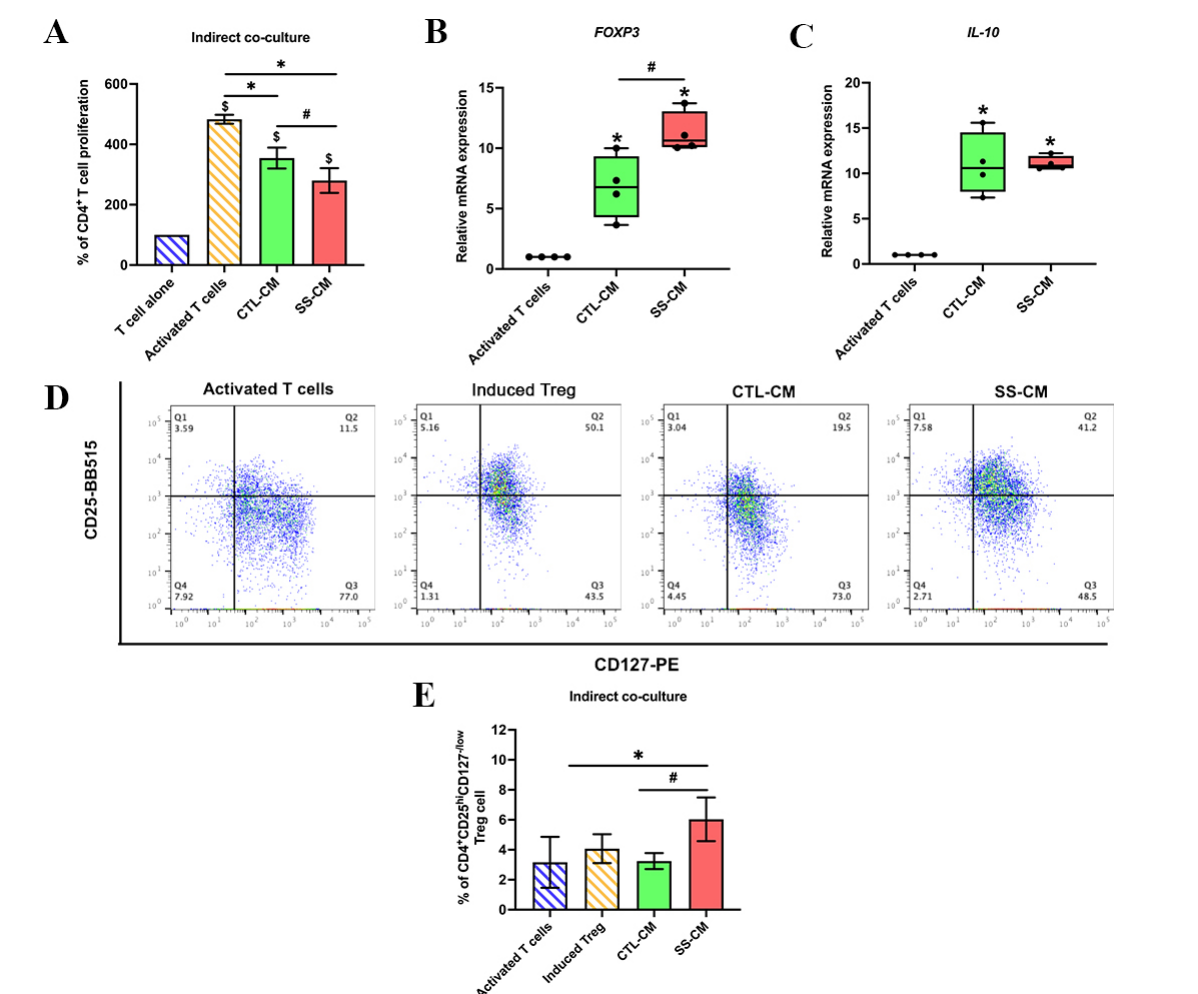
Figure 4. Shear stress attenuated CD4 + T cell proliferation and promoted Treg differentiation. All hPDLSC-derived conditioned media were indirectly co-cultured with CD4 + T cells. The proliferation of CD4 + T cells was assessed using a resazurin assay. SS-CM decreased the percentage of T cell proliferation ( A ). The mRNA expressions of FOXP3 ( B ) and IL-10 ( C ) were upregulated in SS- CM-treated CD4 + T cells. The flow cytometry analysis showed an increase in the percentage of CD4 + CD25 hi CD127 lo / − Treg population in SS-CM compared to CTL-CM and activated T cells ( D , E ). $ p < 0.05 vs. T cell alone group, * p < 0.05 vs. activated T cells group, # p < 0.05 vs. CTL-CM